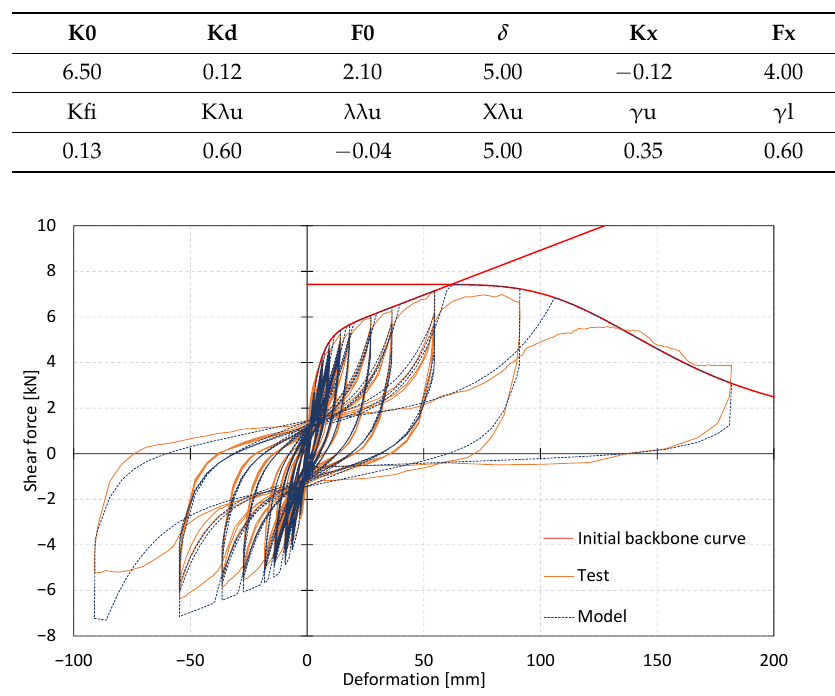
Figure 9. Comparison between test results and prediction (Plywood). Table 3. Set parameters of gypsum board walls per wall (GN40 specification).